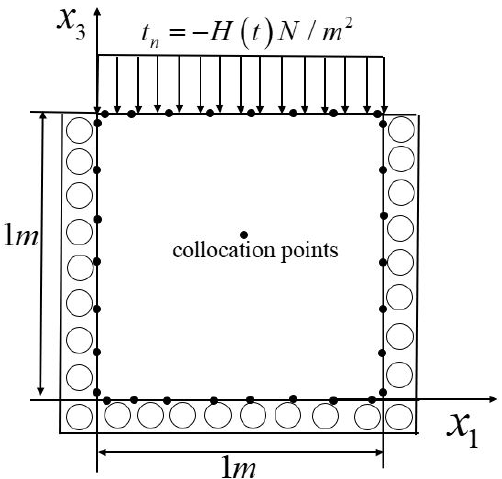
Figure 1. Computational model of saturated column.